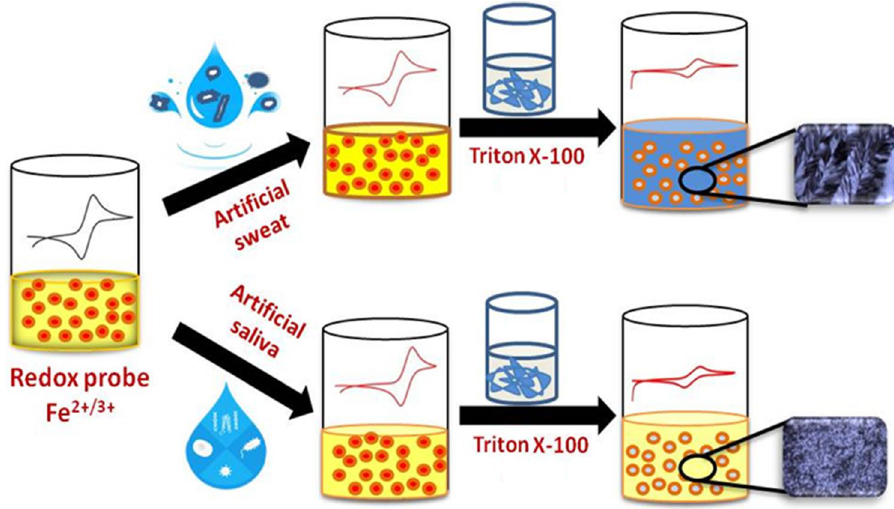
Scheme 1. Pictorial representation of the investigation of Fe 2+/3+ redox couple in unconventional electrolytes formed using artificial sweat and saliva